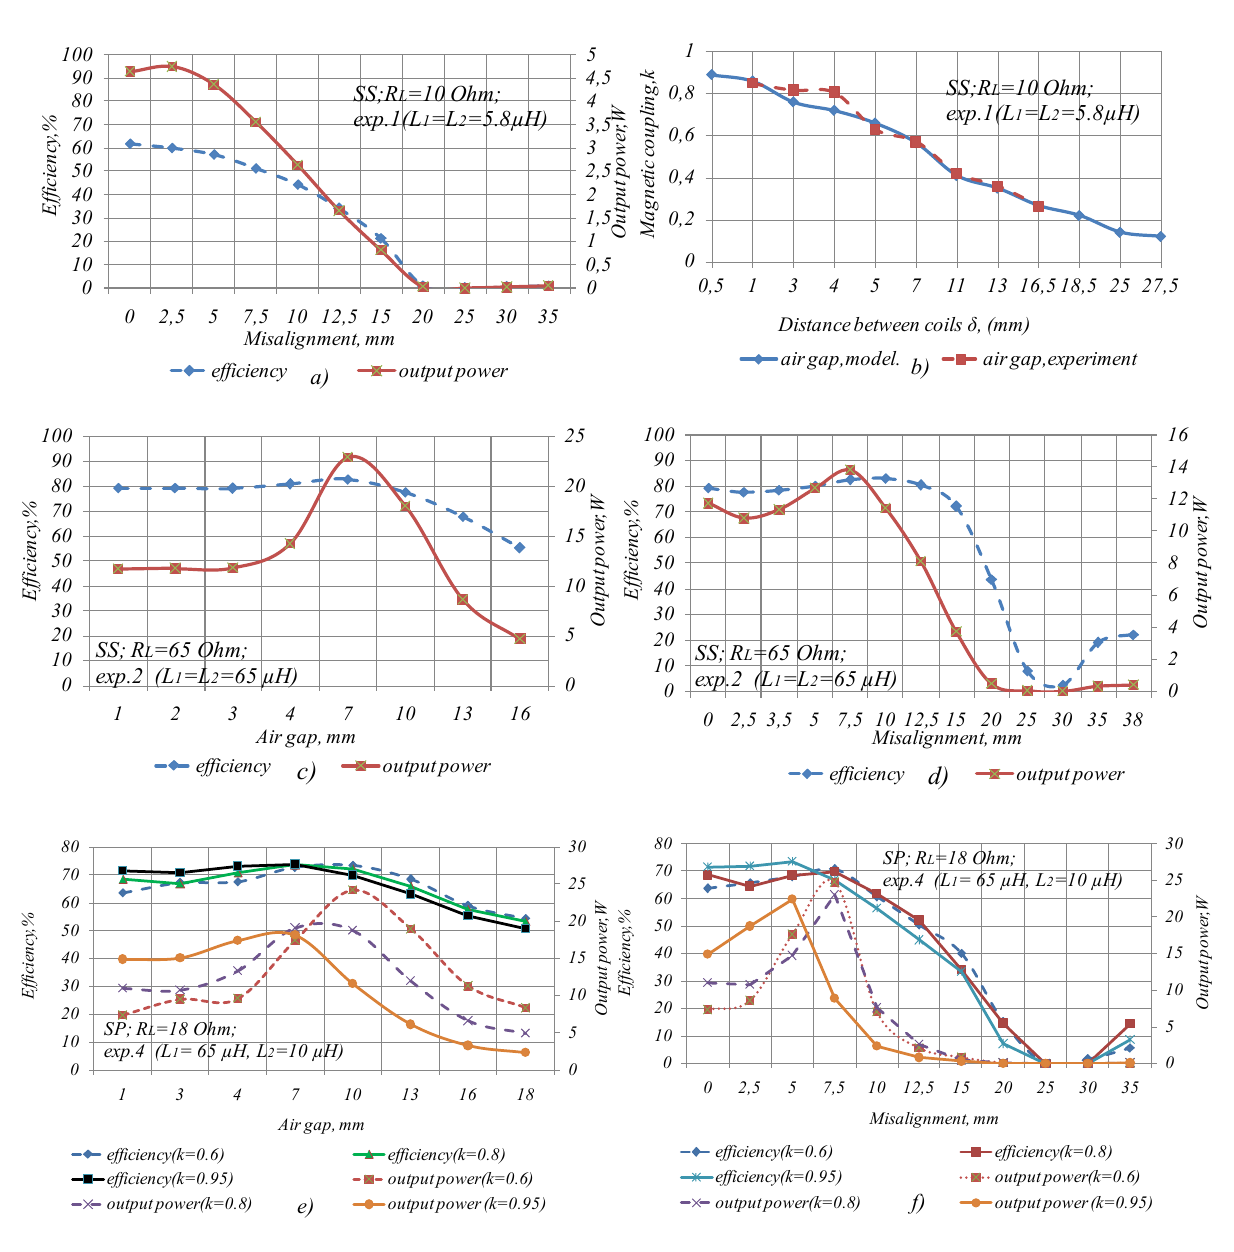
Fig. 4. Simulation and experimental dependences of efficiency and output power from changing the air gap (b, c, e) and lateral misalignment (a, d, f) between